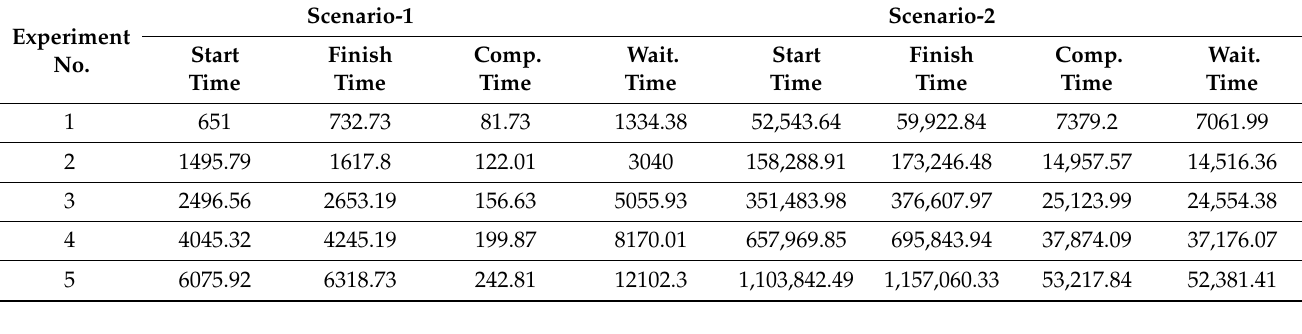
Table 6. Total computation time (ms) and waiting time (ms) in Scenario-1 and Scenario-2.